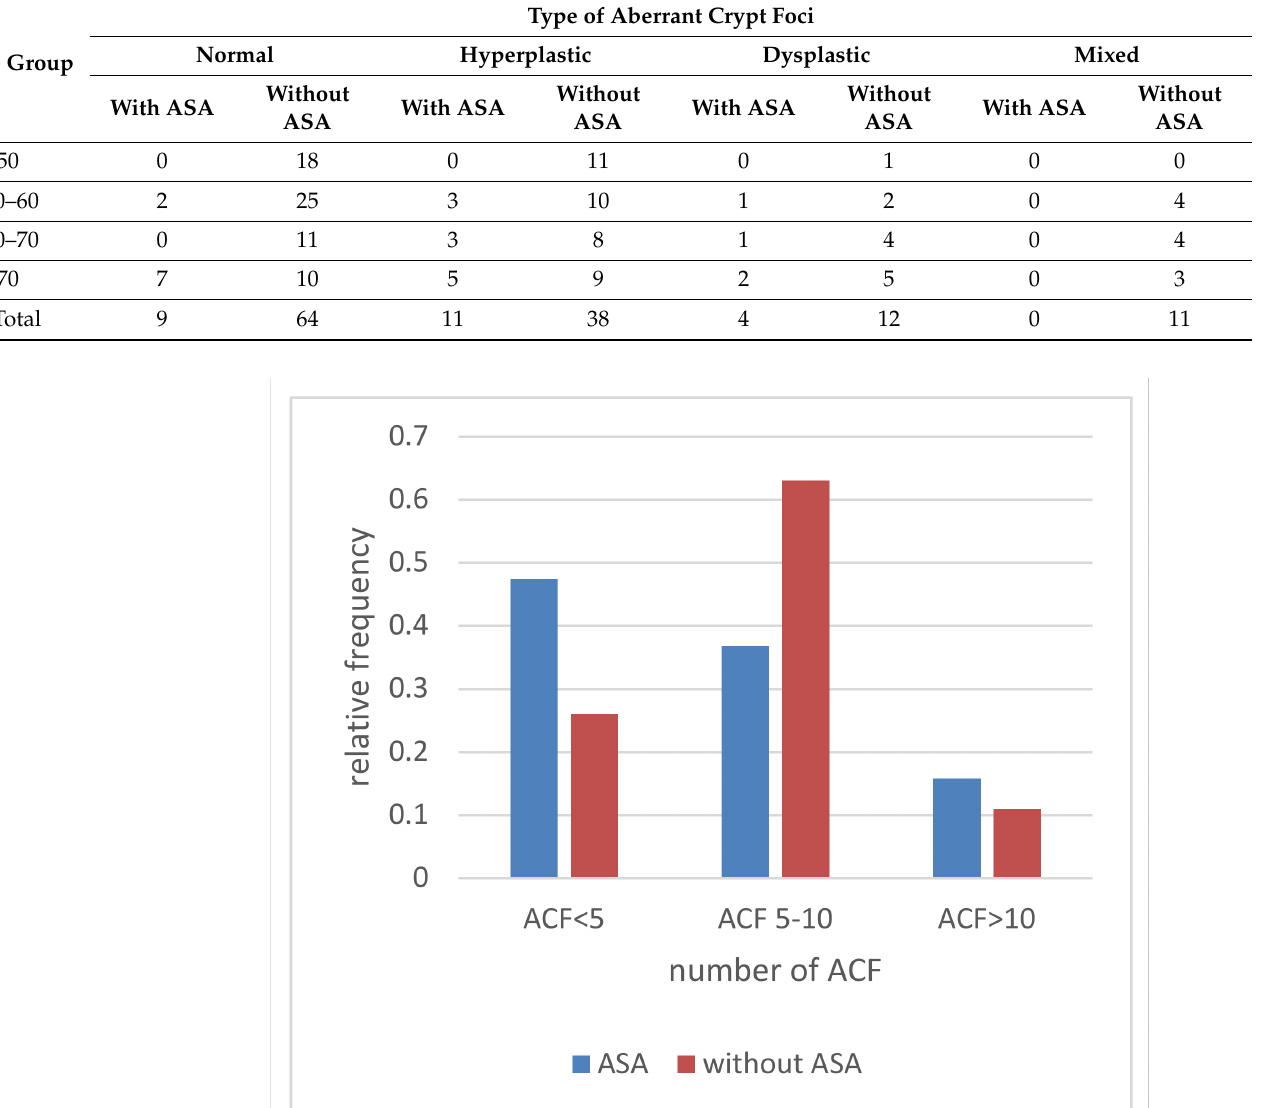
Table 1. Occurrence of ACF types in age groups in the with ASA and without ASA groups.